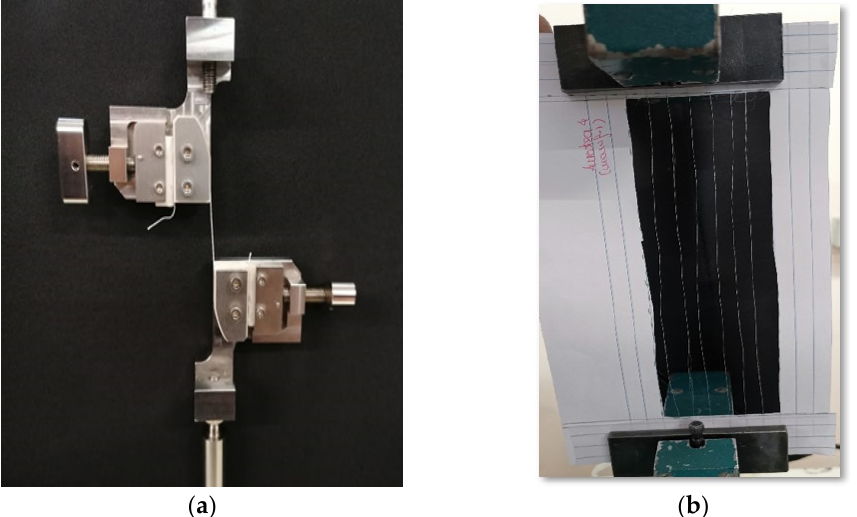
Figure 3. Gripping systems used for monotonic quasi-static tensile tests: ( a ) for most configurations; and ( b ) for 6PY configuration.